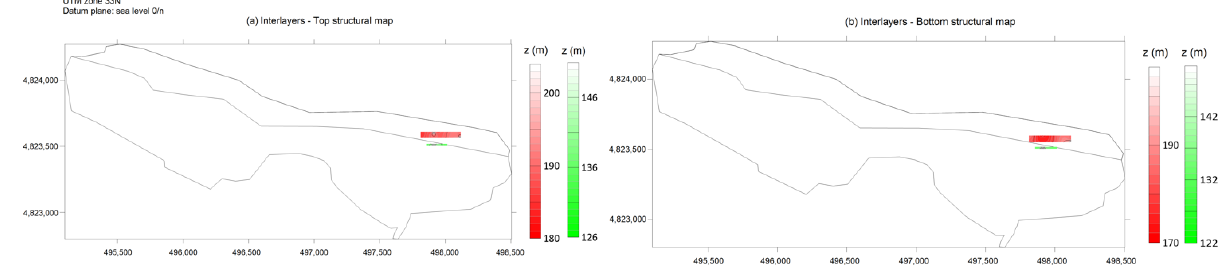
Figure 7. Top and bottom interpolation maps of the interlayers. ( a ): top, ( b ): bottom. The volume of unit 1 calculated using structural maps was 5,808,406 m 3 , while the volume of the interlayers was 276,943 m 3 (Table 2). Interlayers within unit 1 occupy a total of 5% of its volumes. Table 2. Reserve of the unit 1 and interlayers calculated using structural maps.